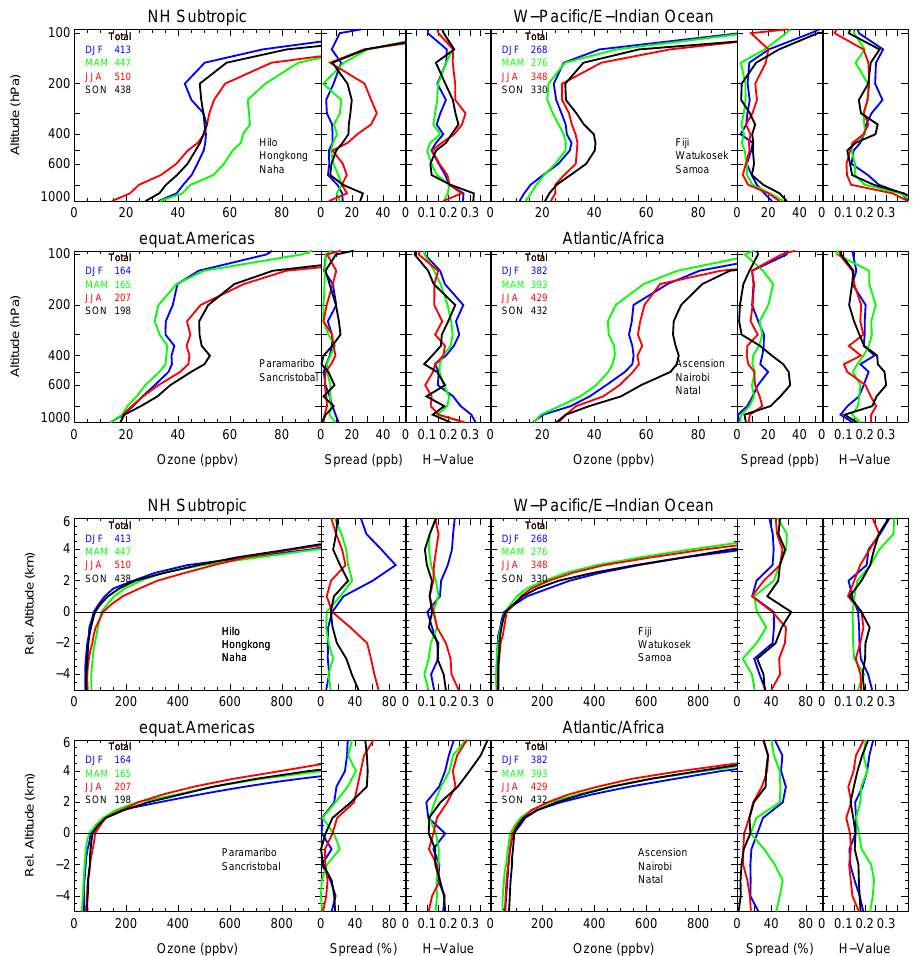
Fig. 12. Same as Figs. 2 and 3, but for the NH Subtropics and three regions in the Tropics.